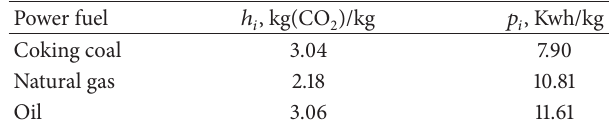
Table 3: Relevant data of fuels.